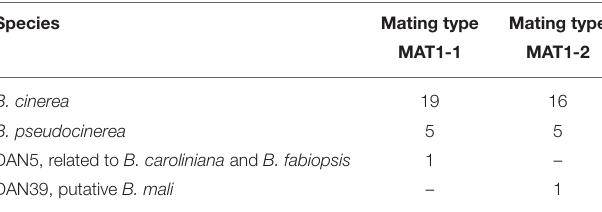
TABLE 4 | Distribution of mating types in 47 Botrytis isolates from dandelion, as determined by diagnostic PCR.